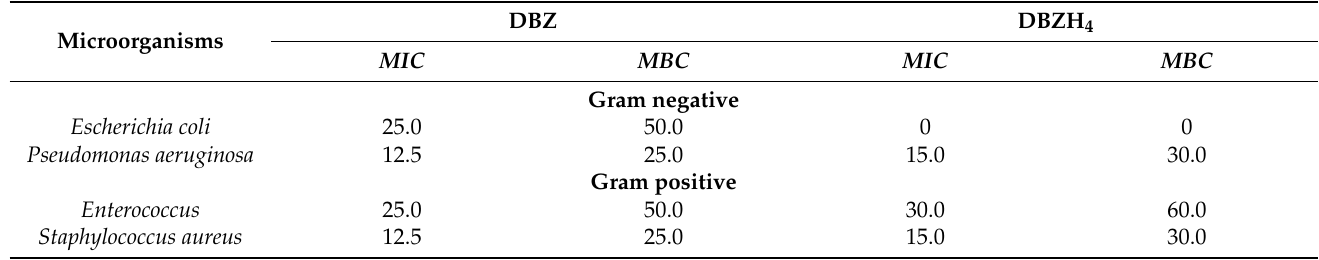
Figure 8. Pictorial bar representation of the antimicrobial activity of DBZ , DBZH 4 and chloramphenicol. Table 4. MIC and MBC values against Gram-negative ( Escherichia coli and Pseudomonas aeruginosa